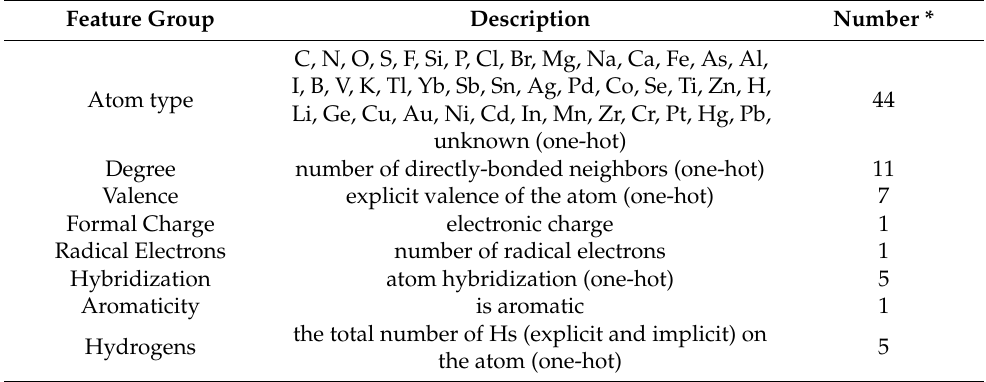
Table 5. Atom feature